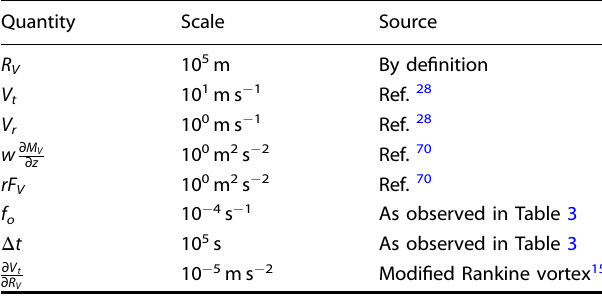
Table 2. Characteristic values of the quantities related to Eq. (4).